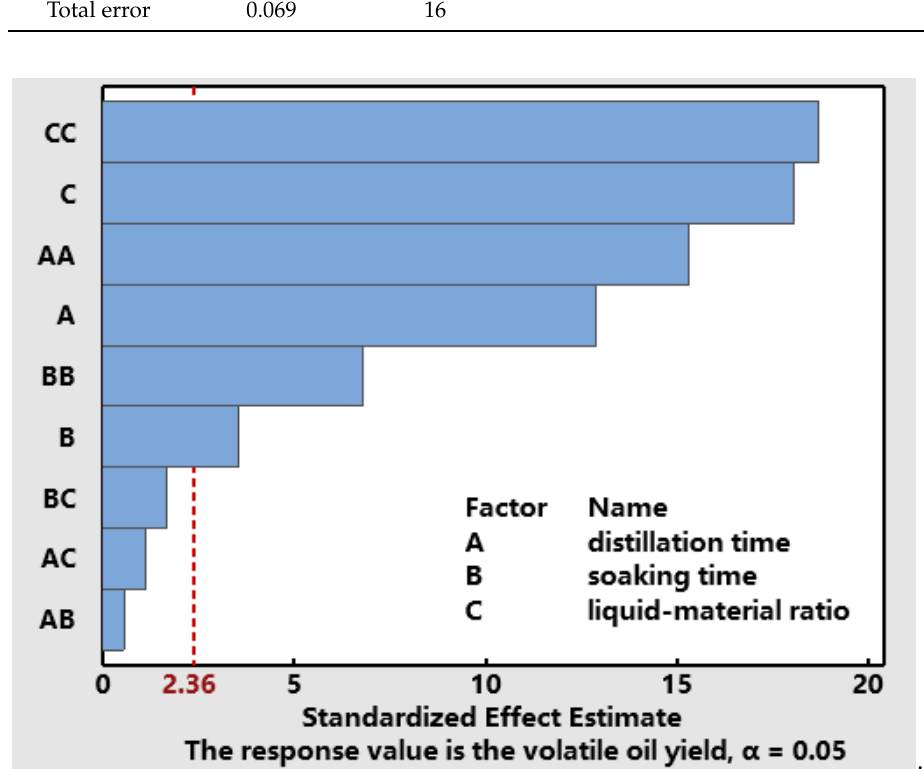
Figure 6. The Pareto chart of the parameters.